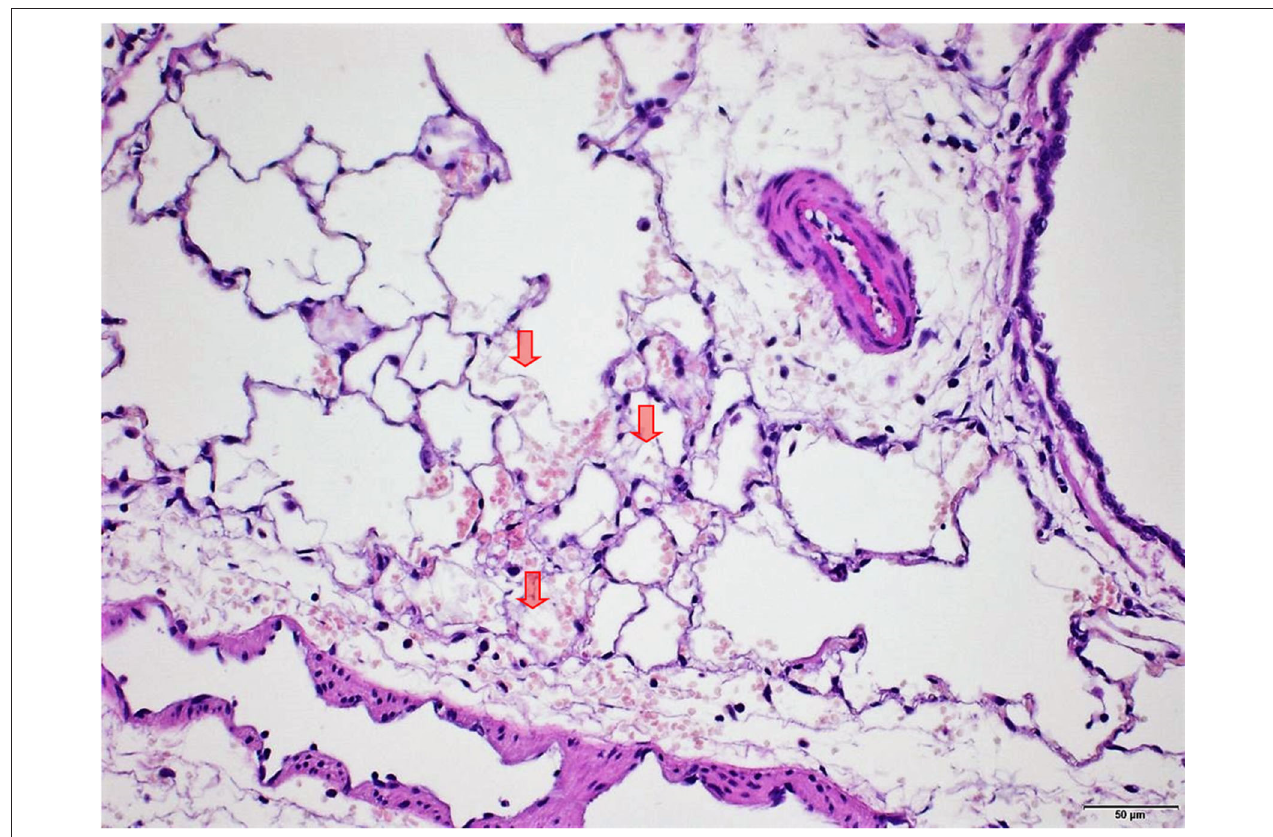
FIGURE 7 | Male rat. Deceased 2 ¾ h after inhalation start. Lung, right caudal lobe. Note fibrin in alveoli (arrows) associated with tiny hemorrhagic foci. HE, original magnification